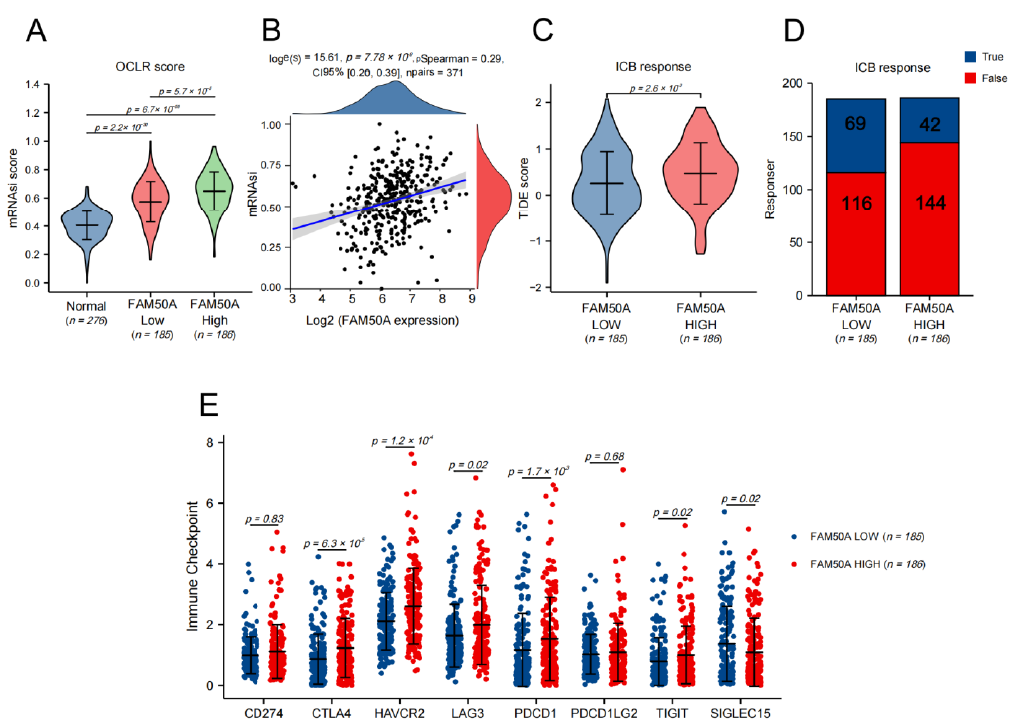
Figure 4. The effects of FAM50A on stemness degree, immunotherapy response and the expression of the immune checkpoint in HCC. We used the OCLR algorithm to calculate the stemness degree and the tumor immune dysfunction and exclusion (TIDE) algorithm to evaluate the response to immune checkpoint blockade (ICB). ( A ) The stemness degrees of 276 normal liver tissues, 185 FAM50A low-expression tissues and 186 FAM50A high-expression tissues. ( B ) Correlation between FAM50A and stemness degree of 371 HCC patients. ( C ) The TIDE scores of 185 FAM50A low-expression tissues and 186 FAM50A high-expression tissues. ( D ) Number of patients with low expressions of FAM50A and patients with high expressions of FAM50A who responded to immunotherapy. ( E ) Correlation between FAM50A and immune checkpoint expression in HCC.